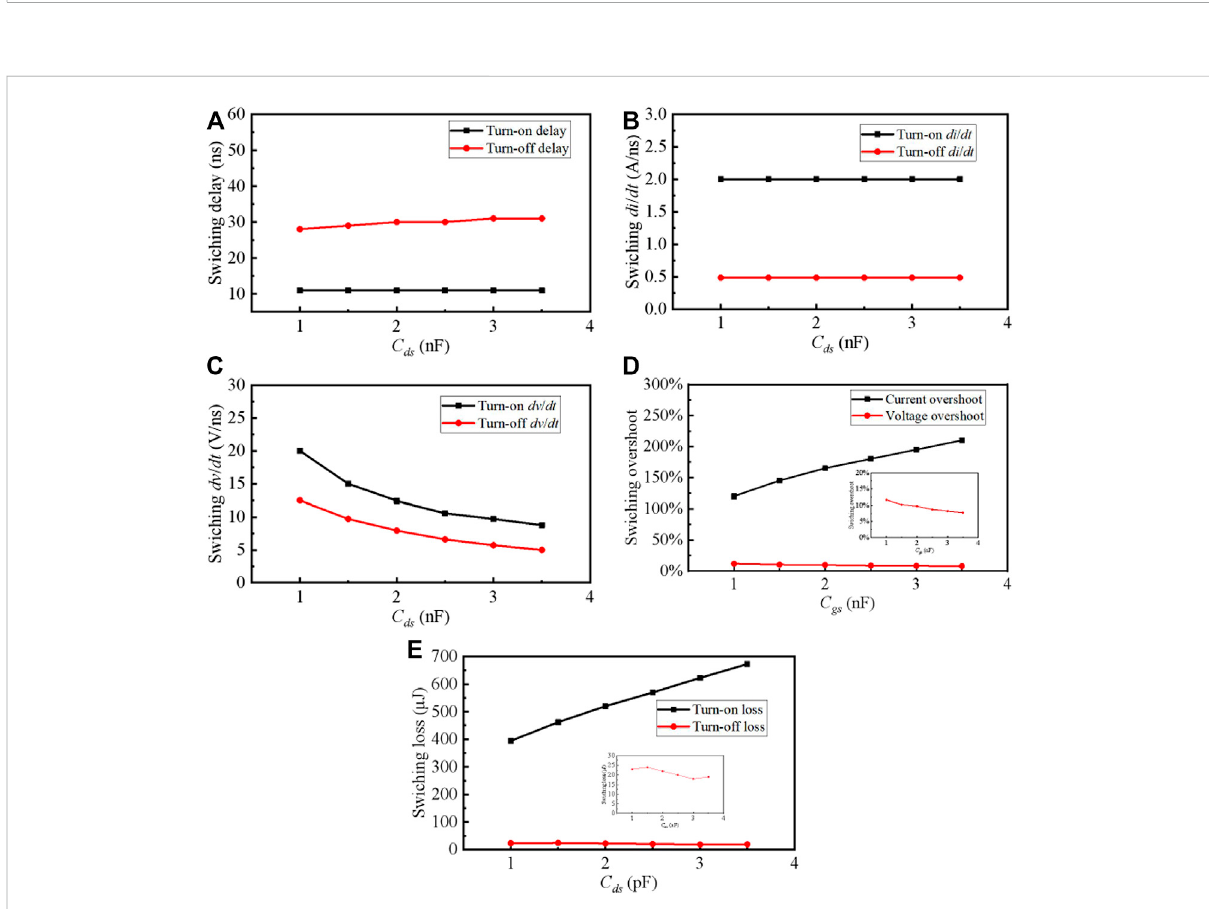
FIGURE 11 Dynamic characteristics of the SiC MOSFET with different C ds . (A) Switching delay. (B) Switching di / dt . (C) Switching du / dt . (D) Switching overshoot. (E) Switching